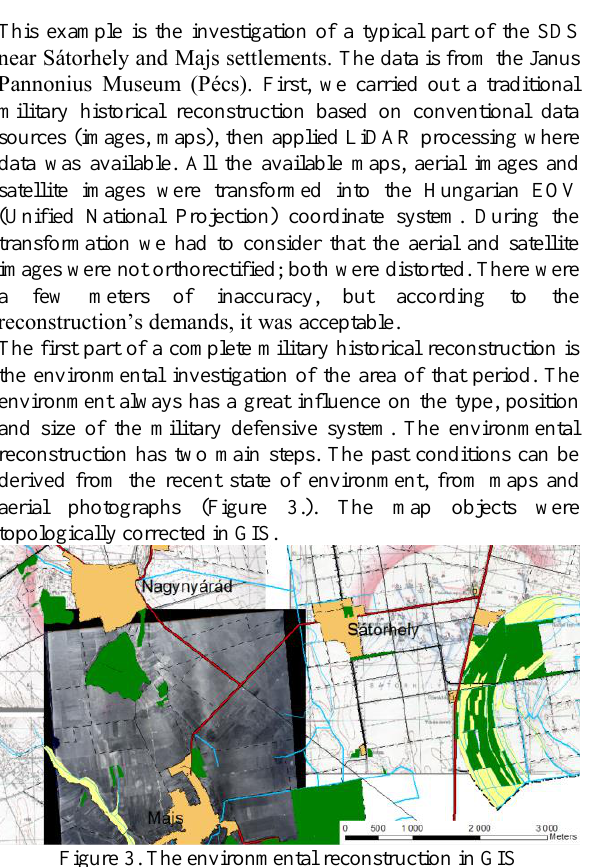
The Figure 2. below represents the results of the fire trench (arrows) detections using different filters (Stal C. et al, 2010).